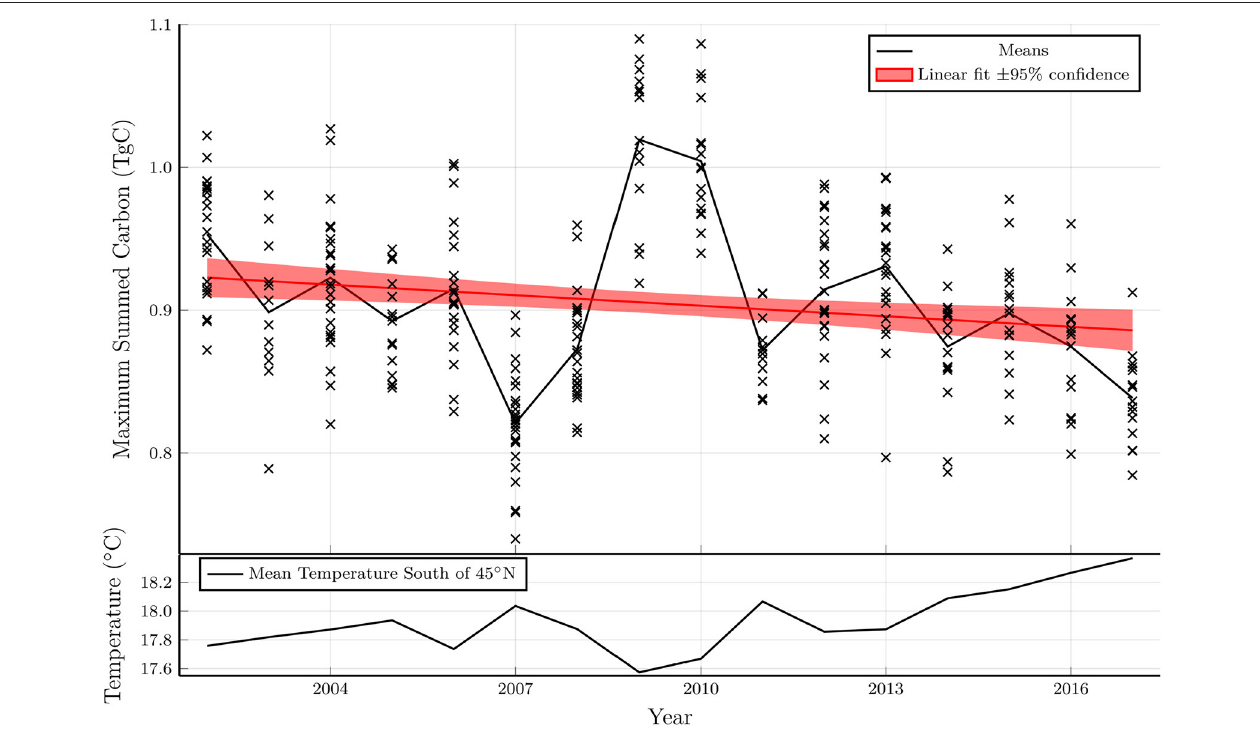
FIGURE 4 | Top : Maximum total carbon of each model run from an ensemble with varying parameters plotted as a function of the model starting year. A linear fit to the model ensemble and a shaded region indicating the 95 % confidence interval of the fit coefficients indicates a statistically significant downward trend. Bottom : Mean temperature averaged from 0 to 75 m in depth, 0–80 ◦ W in longitude and 35–45 ◦ N in latitude.